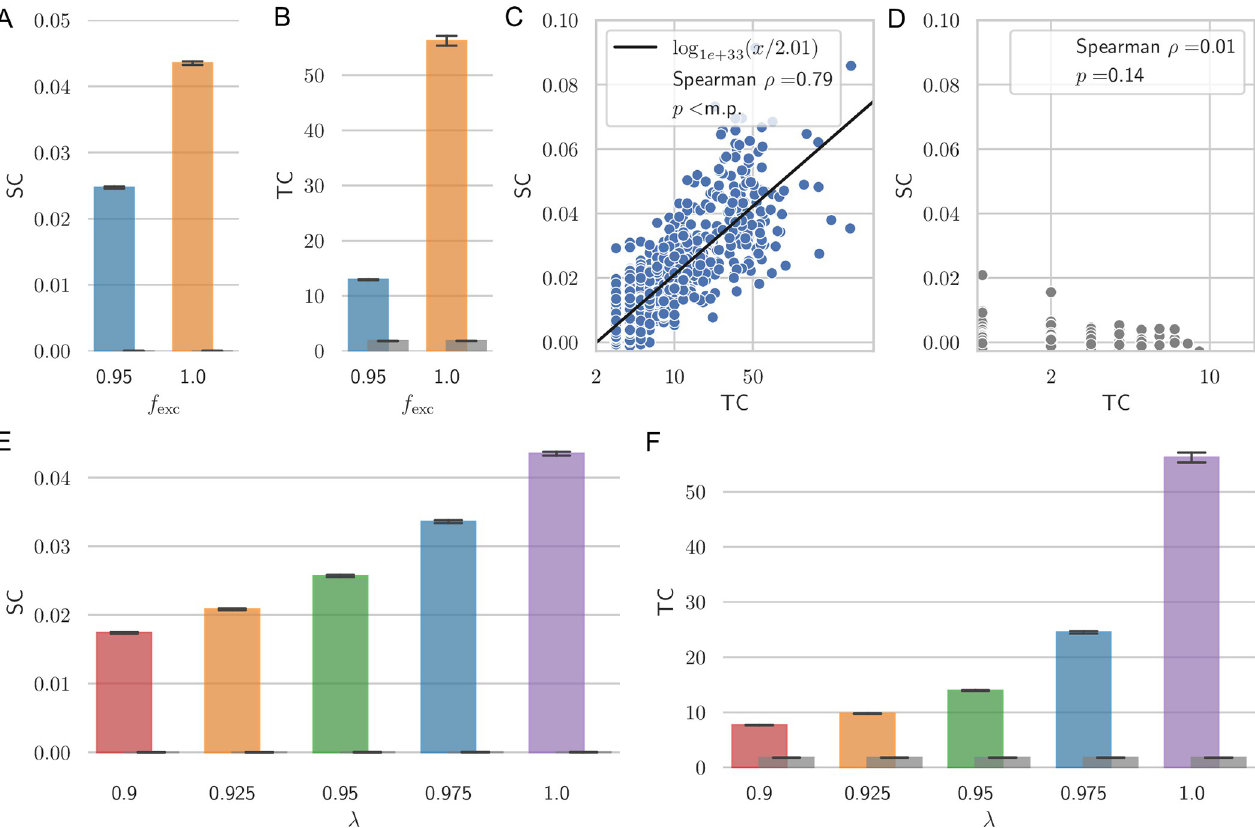
Fig 4. STC in a neural network model. Model simulations are shown for N = 1600 neurons on a 2-dimensional grid with periodic boundary conditions and distance-dependent connectivity strength. Other parameters are f inh = f exc = λ = 1, if not stated otherwise. One neuron was activated randomly every max t = 2000 time steps. Coloured bars give the ensemble average with whiskers extending to the 95% confidence interval. Results for surrogate data (shuffled time series) are given as grey bars. A, B The state of high AED can be mimicked in the model by decreasing the excitability of excitatory neurons, i.e., f exc = 1 ! 0.95, leading to decreased SC, TC. C Co-variation between TC and SC for different model realizations with λ 2 {0.7, 0.75, 0.8, 0.85, 0.9, 0.95, 1.0} (10 4 runs each, 7 � 10 4 runs in total, Spearman ρ = 0.79, p < m.p. (machine precision)). The black line shows a logarithmic fit. D No correlations are found in time-shuffled data. E, F SC and TC increase with the absolute value of the largest eigenvalue λ approaching its critical value of λ = 1 similar to the hierarchical increase of TC in iEEG data (Fig 3).